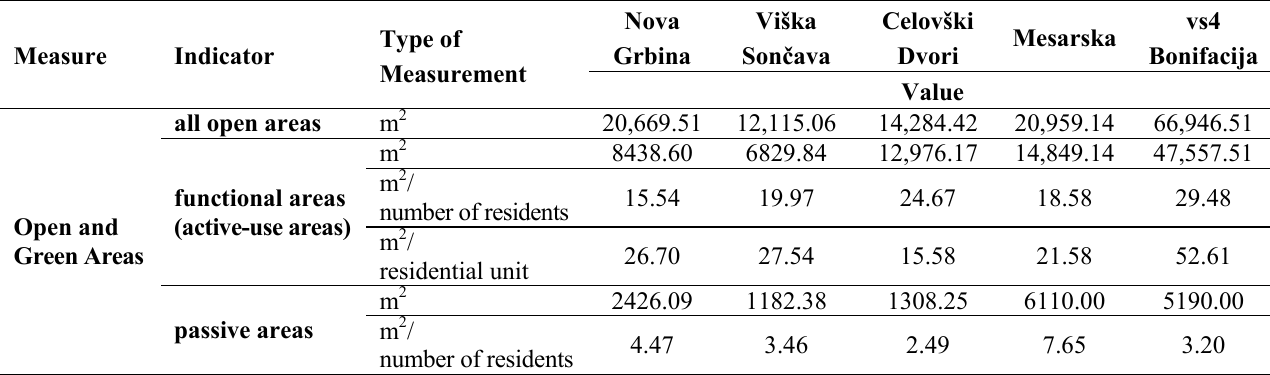
Table 3. Evaluation of residential areas: spatial mesaure “open and green areas”, described by different indicators (all open areas, functional areas—excluding private groundfloor atrium gardens, roads and external car park areas, passive areas—atriums, private use). Nova Viška Celovški vs4 Mesarska Type of Grbina Son č ava Dvori Bonifacija Measure Indicator Measurement Value all open areas m 2